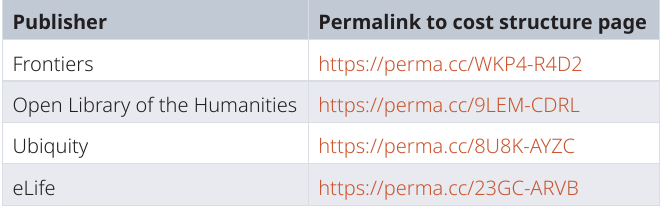
Table 2. Published itemized cost structures from publishers/ service